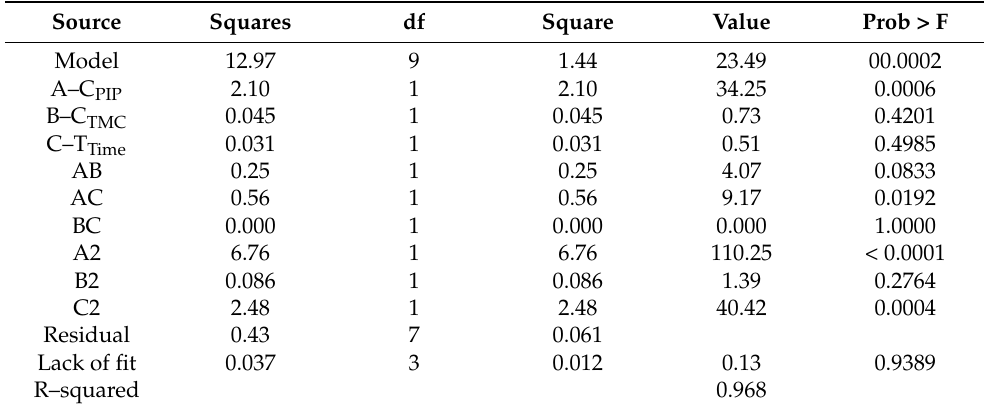
Table 4. Variance analysis of IP–ZrO 2 /BC–NFM quadratic polynomial model for sodium chloride